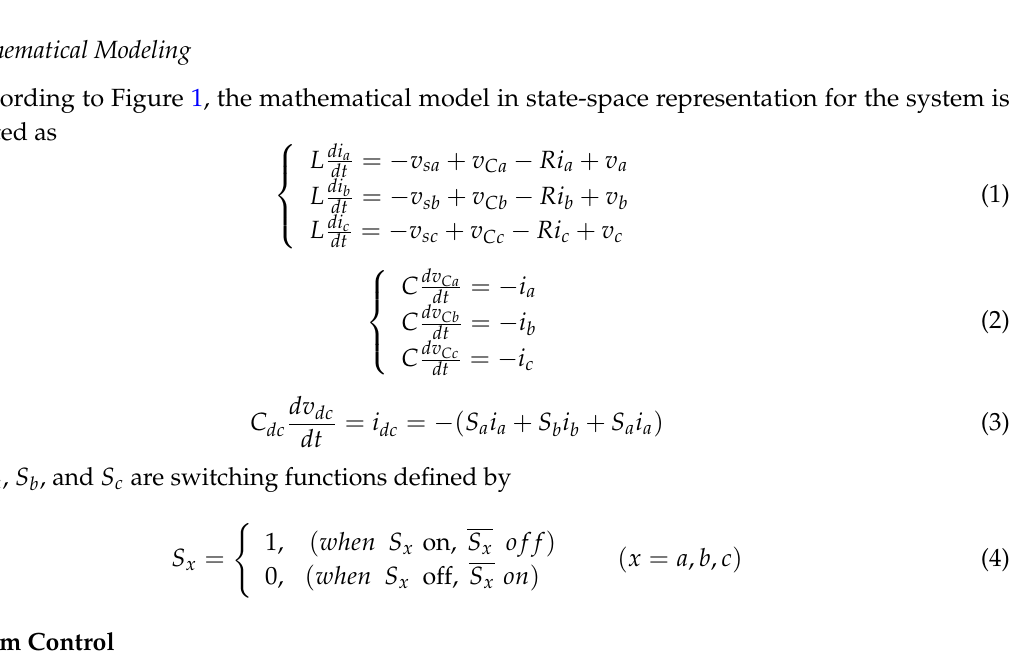
Figure 1. Topology of parallel hybrid active power filter.